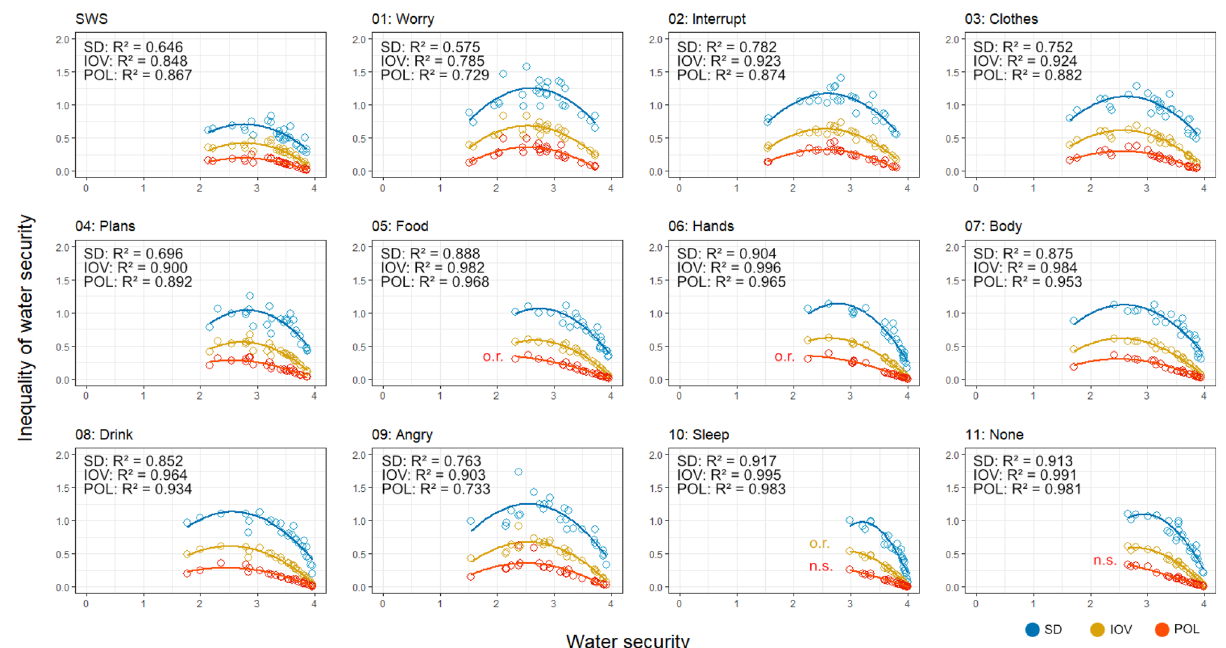
Fig. 3 Inverted U-shaped relationship between different water security and inequality indices. Water security indices include composite WS score and the 11 comprising items, and inequality indices include SD, IOV, and POL. Sample size = 28. A more stringent two-sided p -value threshold at 0.01 was used to counteract the potential problem of multiple comparisons. n.s. denotes the quadratic regression model is not statistically signi fi cant while o.r. denotes the extremum point is out of the range of the available data. See Supplementary Table 4 for